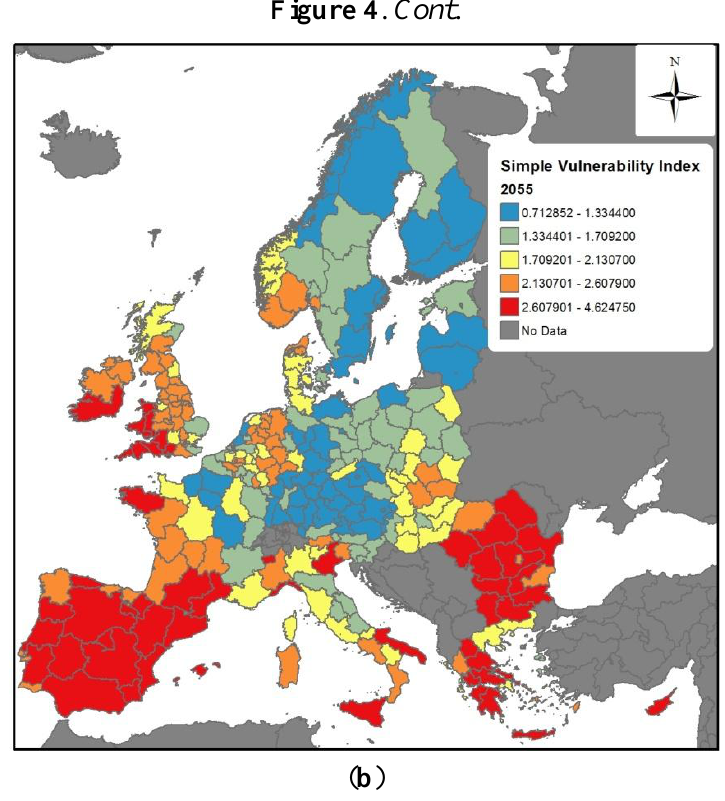
Figure 5. Fractional contribution of the precipitation and temperature components to the value of the Simple Impact Index for 2035 (averaged over each EU Member